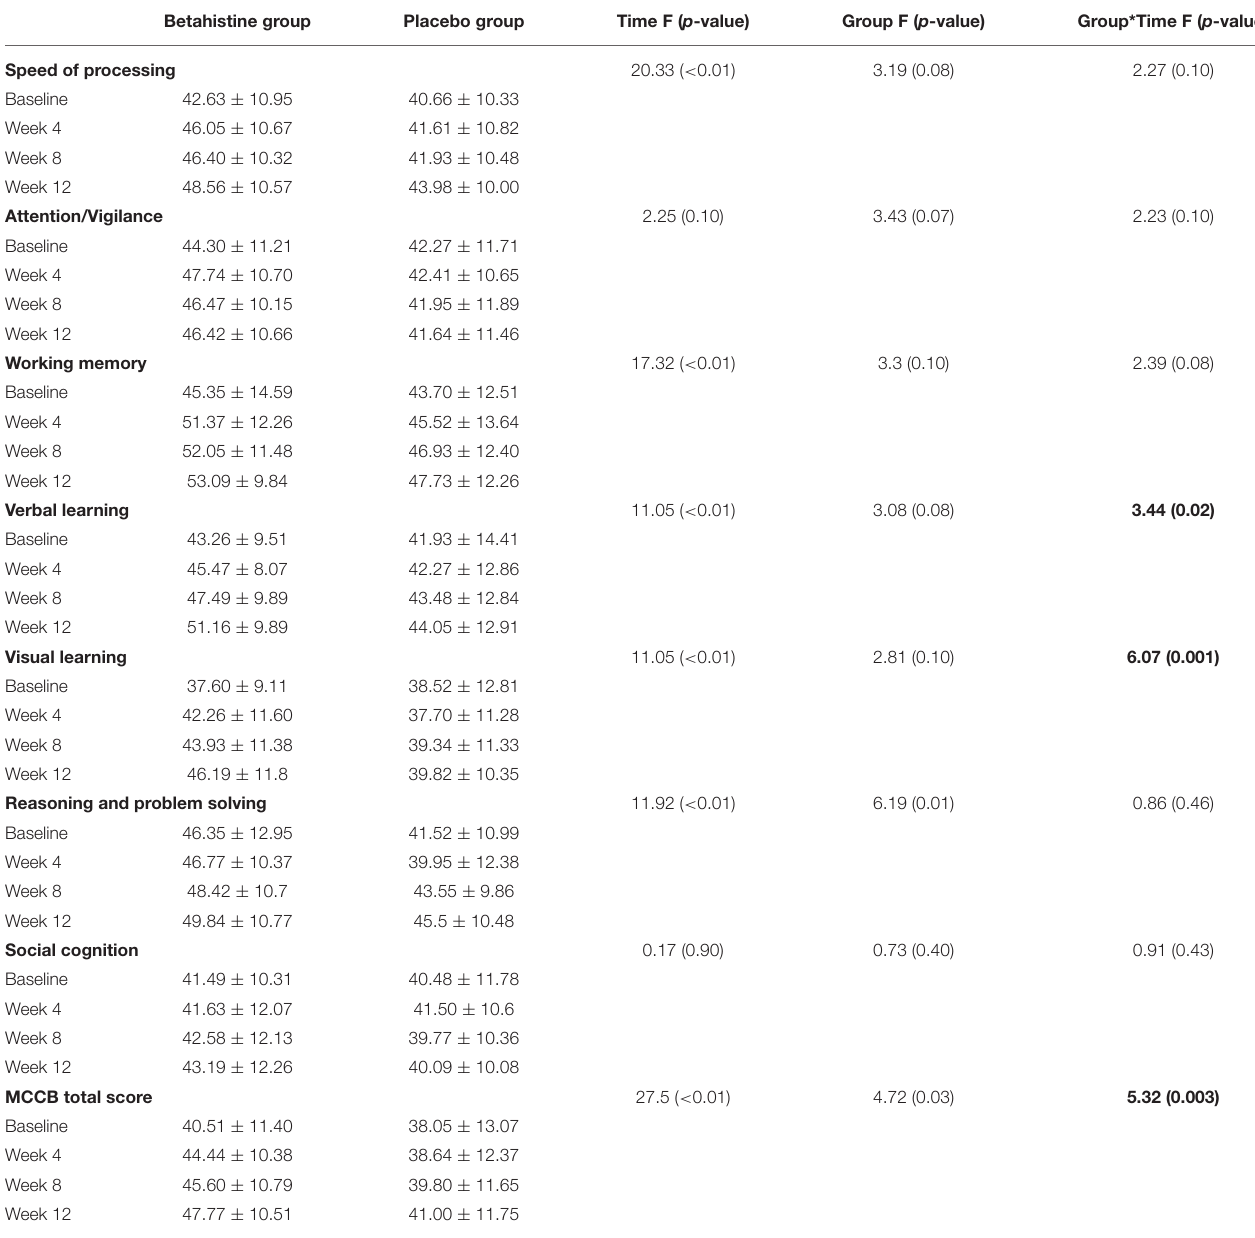
TABLE 2 | MCCB total and subscale scores at baseline and weeks 4, 8, and 12 in the betahistine and placebo groups. Betahistine group Placebo group Time F ( p -value) Group F ( p -value) Group*Time F ( p -value) Speed of